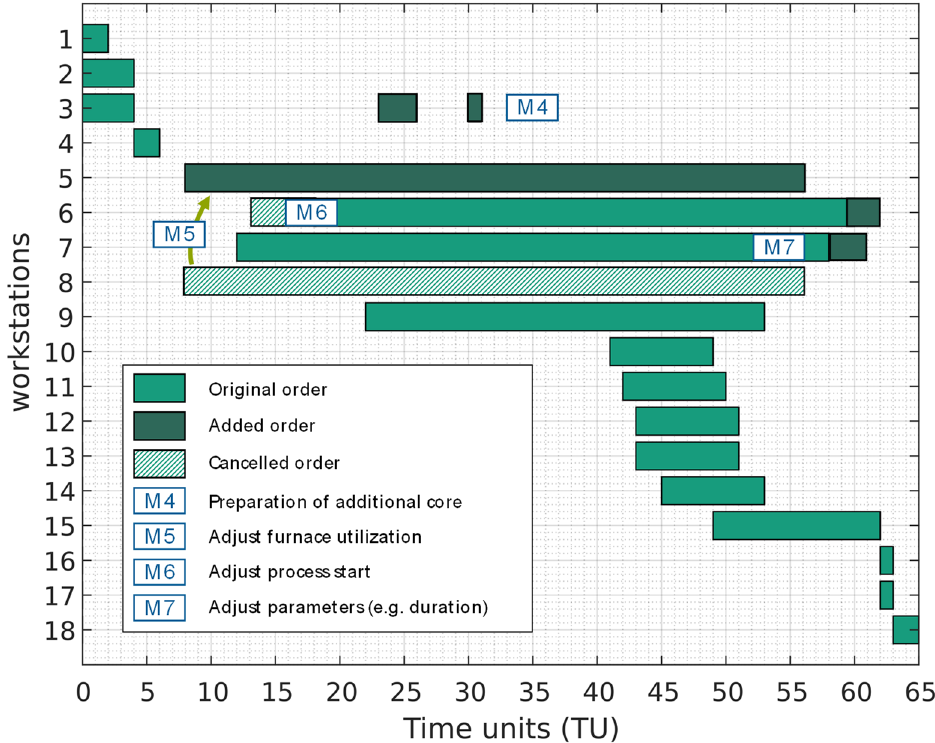
Figure 7. Risk-treated production schedule Gantt chart with marked reactive and preventive measures.